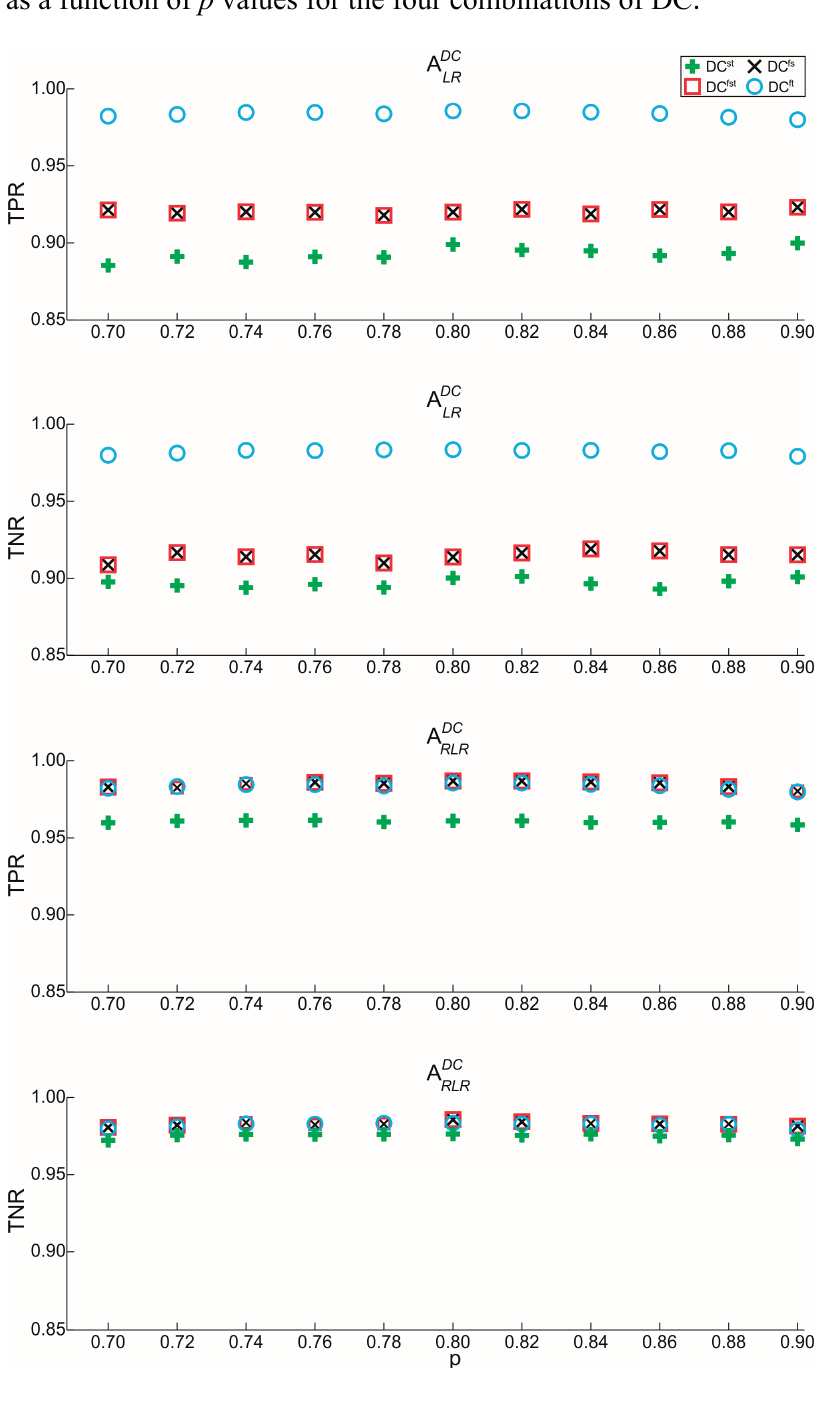
Figure 6. Values of True Positive Rate ( TPR ) and True Negative Rate ( TNR ) evaluated for A DC and A DC as a function of p values for the four combinations of DC LR RLR